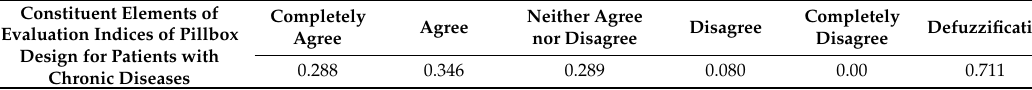
Table 6. Degrees of conformity of index framework for evaluation by